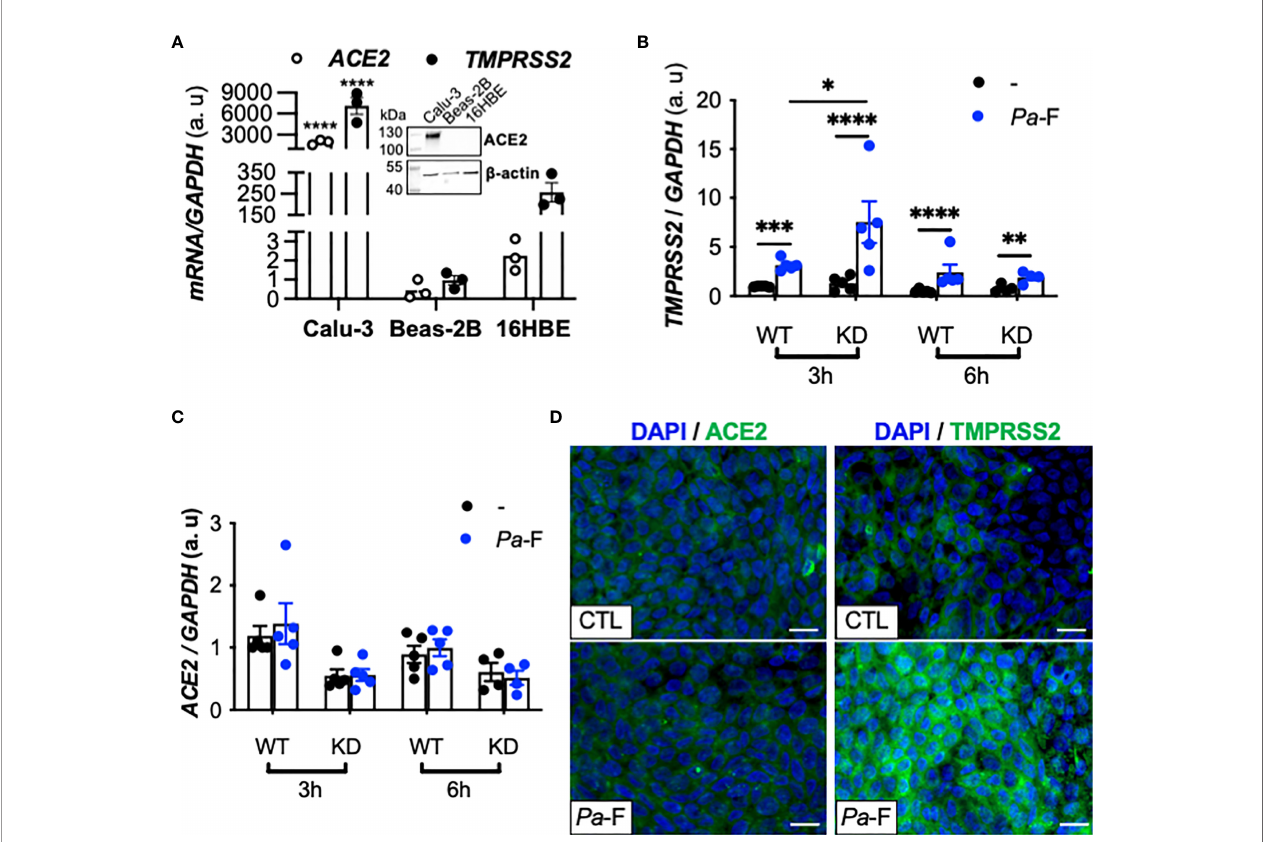
FIGURE 2 | Effect of P. aeruginosa fl agellin on ACE2, FURIN, and TMPRSS2 expression in CFTR -de fi cient Calu-3 cells. (A) ACE2 and TMPRSS2 mRNA expression in submerged cultures of Calu-3, Beas-2B (reference), and 16HBE14o- cell lines ( n = 3, ANOVA with Dunnett ’ s multiple-comparison test, control group: Calu-3, **** P < 0.0001). GAPDH , housekeeping gene. Representative western blot (with 20 m g of protein) showing ACE2 and b -actin protein expression in submerged cultures of Calu-3, Beas-2B, and 16HBE14o- cell lines. TMPRSS2 (B) and ACE2 (C) mRNA expression (relative to that of housekeeping gene GAPDH ) in Calu-3- CFTR -WT (reference group) and - CFTR -KD cells grown at the air-liquid interface and either not stimulated ( – ) or stimulated for 3 or 6 h with P. aeruginosa fl agellin ( Pa -F, 50 ng/ mL) ( n = 5, ANOVA with Bonferroni ’ s multiple-comparison test, * P < 0.05, ** P < 0.01, *** P < 0.001, **** P < 0.0001). (D) Immuno fl uorescence analysis of TMPRSS2 and ACE2 protein expression in Calu-3 cells (ATCC) grown at the air-liquid interface and stimulated with Pa -F for 18 h; scale bar, 20 m